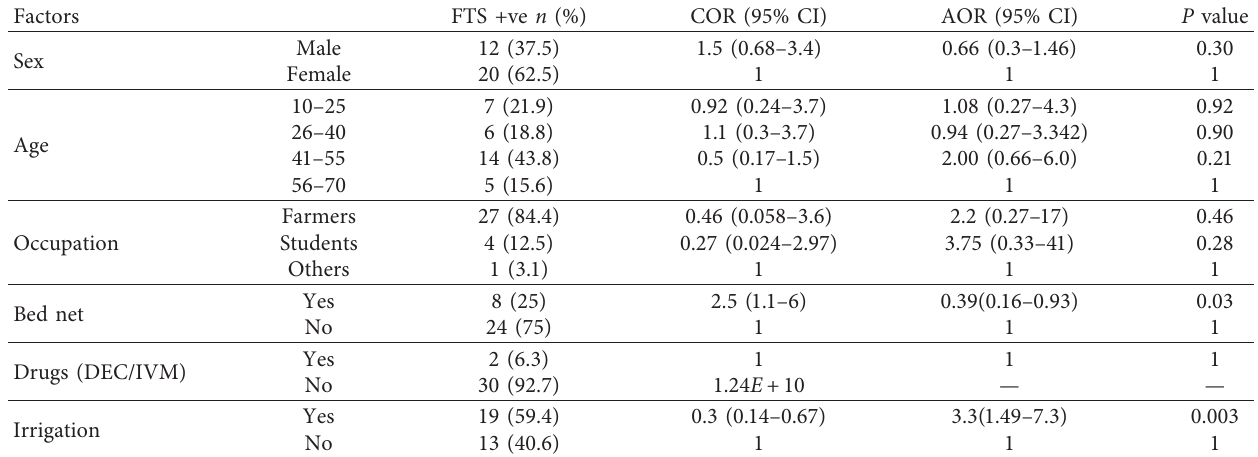
Table 8: Multivariate logistic regression analysis of associated risk factors of LF ( n � 32) in Jeldu district, West Shoa, Ethiopia.